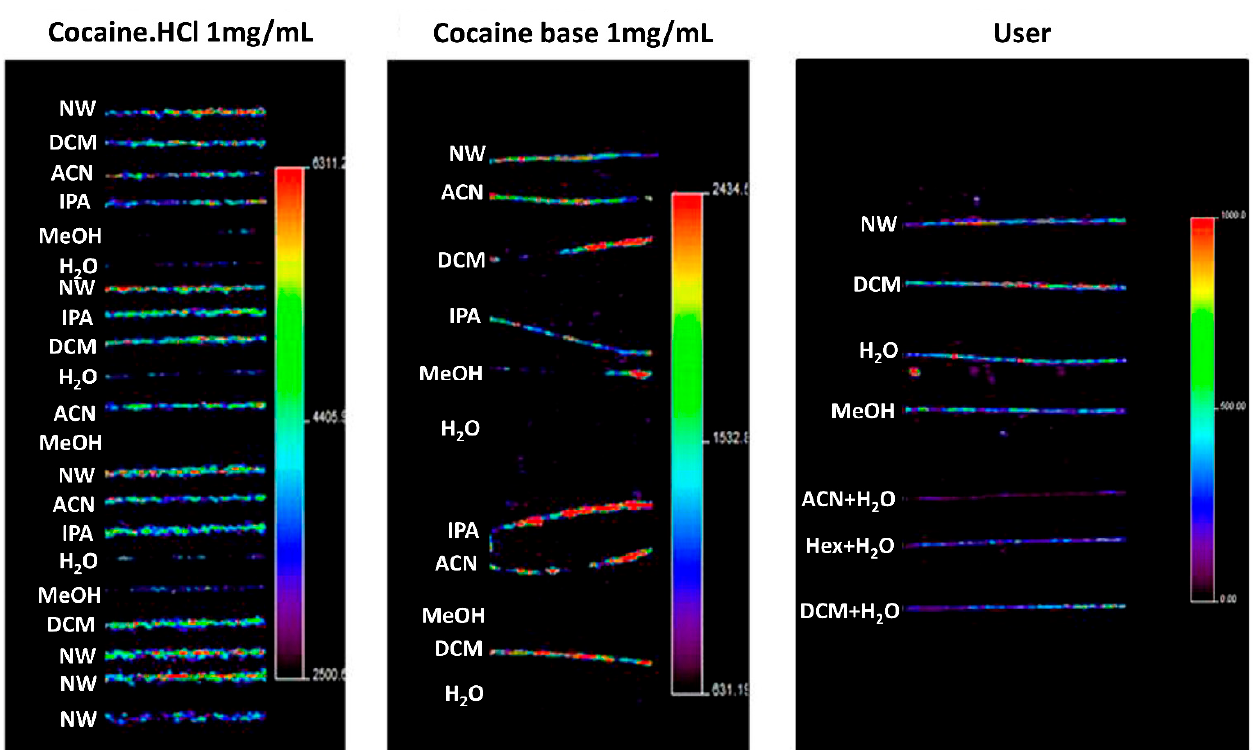
Figure 4. MSI imaging of the cocaine precursor ion in contaminated and users’ hairs, illustrating the effects of washing for 1 min in different washing solutions. Hair strands contained cocaine after being contaminated using a cocaine · HCl stock solution (left panel), using cocaine base (middle panel), and after cocaine use (right panel). The authors noted that washing with water and methanol significantly decreased cocaine concentrations in contaminated samples. However, it was also found that this washing procedure seems to cause migration of external contaminants into the hair cortex and medulla. NW, no wash; DCM, dichloromethane; ACN, acetonitrile; IPA, isopropanol; MeOH, methanol; H 2 O, water; Hex, hexane. Images show a significant reduction in cocaine contamination after washing with methanol, water or both. Figure reprinted and modified from [87]. Copyright (2021) American Chemical Society.